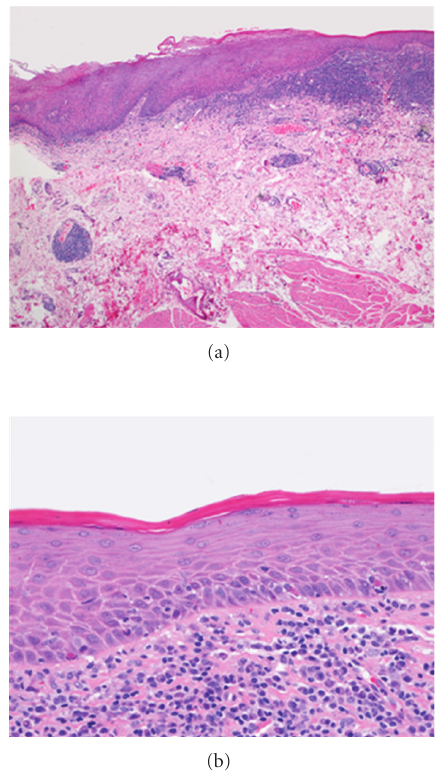
Figure 2: A biopsy taken from a lichenoid lesion. Photomicro- graphs show oral mucosa covered by stratified squamous epithe- lium which is atrophic and orthokeratinized. (a) The superficial lamina propria contains a dense and a well-demarcated lympho- plasmacytic infiltrate. A perivascular lymphoplasmacytic infiltrate also present in the deeper lamina propria. (b) There is thickening of basement membrane region, loss of well-defined basal cell layer, and frequent keratinocyte apoptosis. Photomicrographs; courtesy of Prof Edward